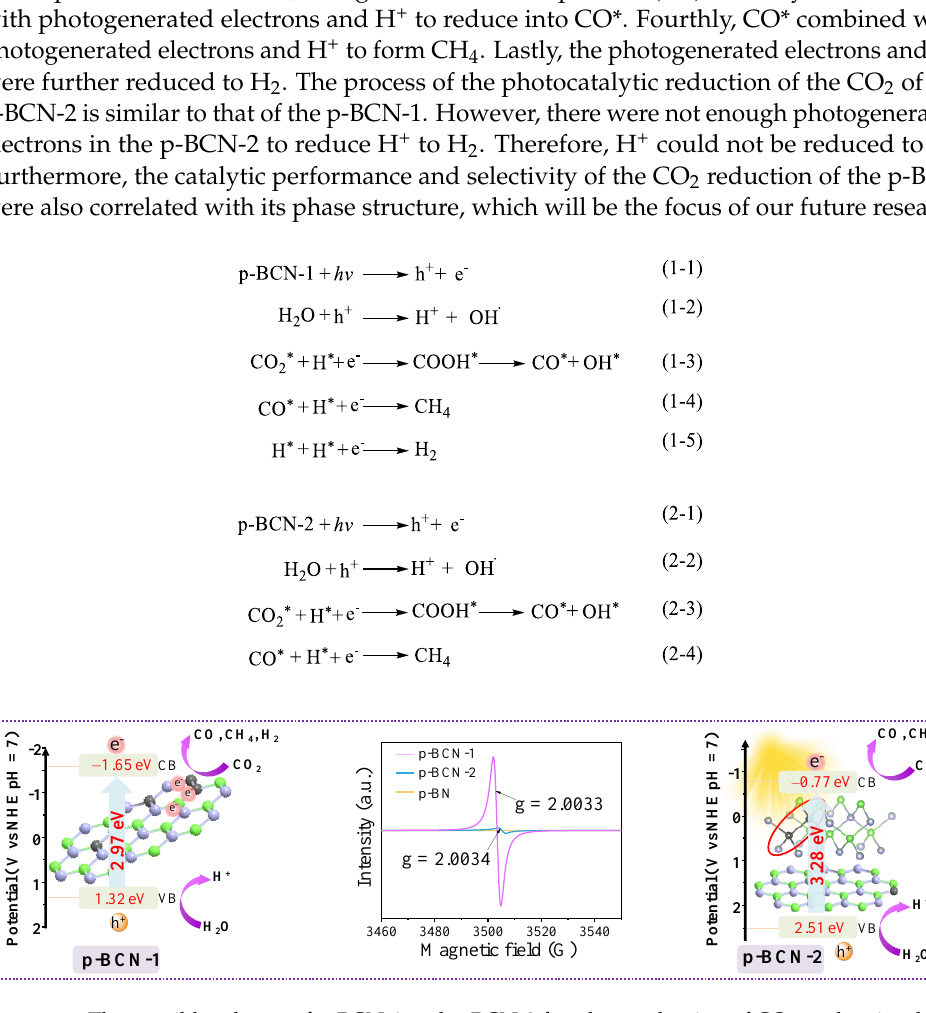
Figure 14. The possible scheme of p-BCN-1 and p-BCN-2 for photoreduction of CO 2 under simulated solar irradiation.